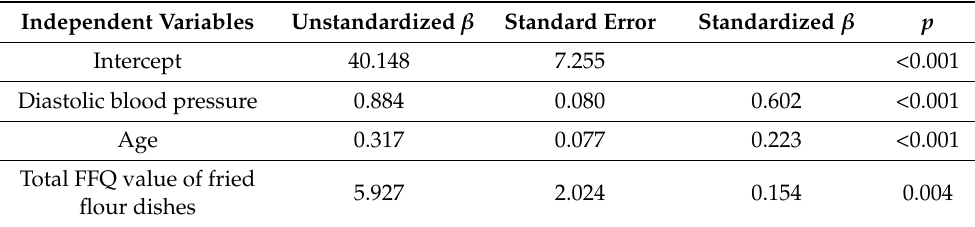
Table 5. Results of multiple regression analyses with the total FFQ value of fried flour dishes for males.